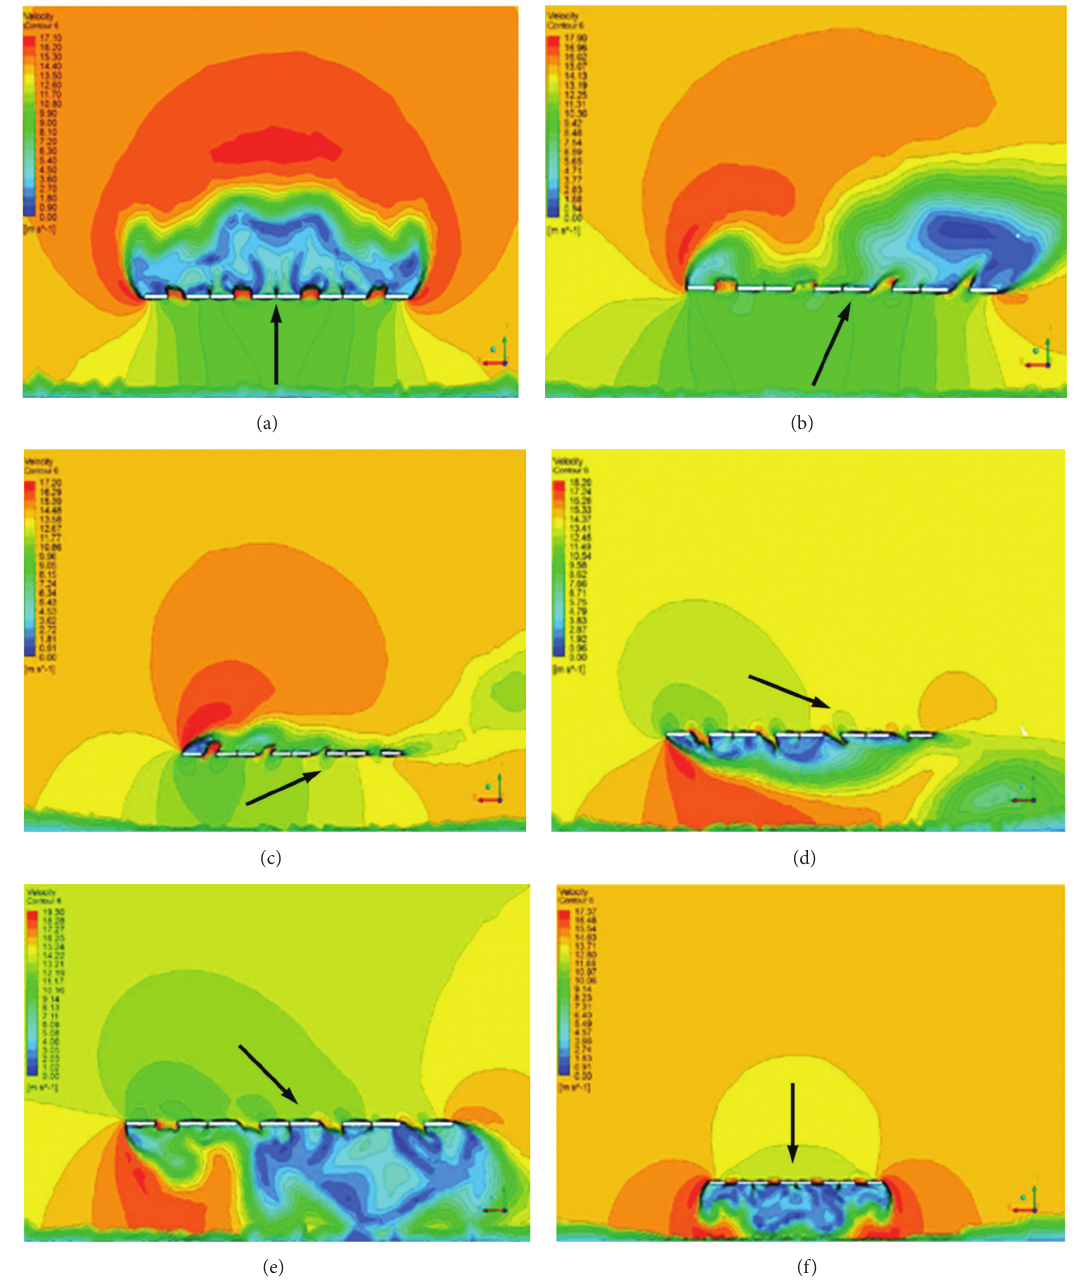
Figure 21: Velocity magnitude (m/s) contours at maximum upwind velocity 14.0 m/s. Panels with holes at (a) 0.0 ∘ , (b) 30.0 ∘ , (c) 60.0 ∘ , (d) 120.0 ∘ , (e) 150.0 ∘ , and (f) 180.0 ∘ approach angles, Section 2 , Figure 12; arrows show the wind direction (azimuthal